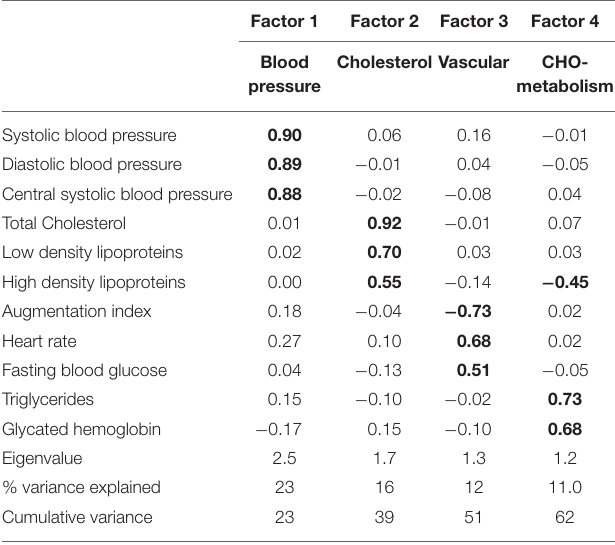
Bold numbers represent variables with a factor loading 0.4.